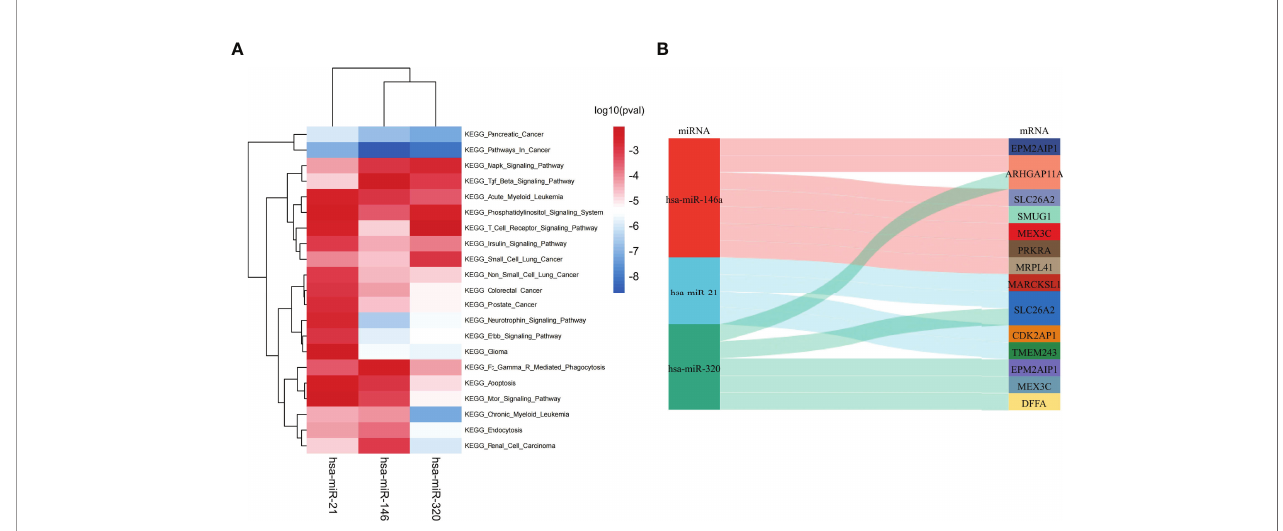
FIGURE 4 | Identi fi cation of shared miRNAs. (A) KEGG enrichment analysis of 3 shared miRNAs (hsa-miR-146, hsa-miR-21, and hsa-miR-320). (B) The sankey diagram of 3 shared miRNAs and 14 down-regulated SDEGs.